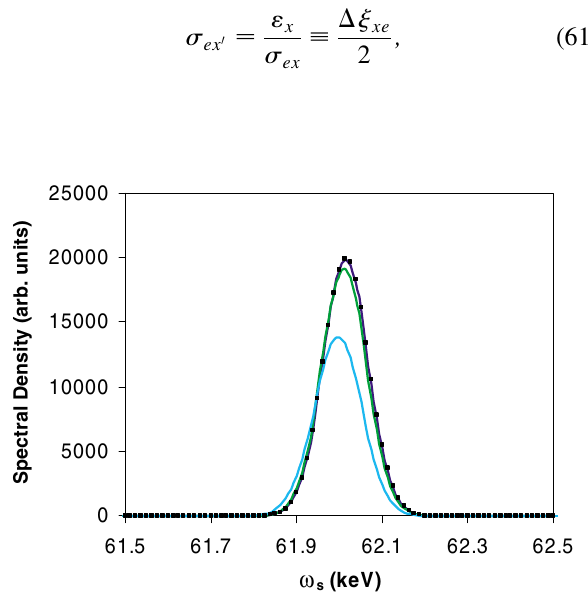
FIG. 7. (Color) On-axis x-ray spectrum produced by a (cid:15) (cid:2) 100 electron colliding head on with an 800 nm laser pulse with a bandwidth corresponding to a 0.5 ps 1 =e 2 pulse width for the case of a plane wave (dots), 20 (cid:18) m laser focus (dark blue line), 10 (cid:18) m laser focus (green line), and 5 (cid:18) m laser focus (light blue line).